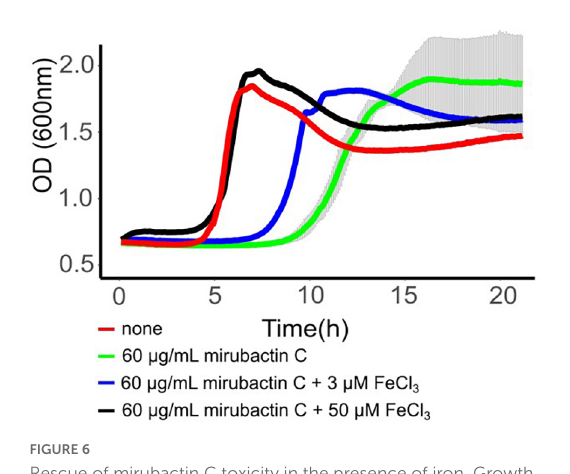
FIGURE6 Rescue of mirubactin C toxicity in the presence of iron. Growth behavior of Bacillus subtilis 168CA; no addition (red), 60 µ g/ml mirubactin C (green), 60 µ g/ml mirubactin C and 3 µ M FeCl 3 (blue) and 60 µ g/ml mirubactin C and 50 µ M FeCl 3